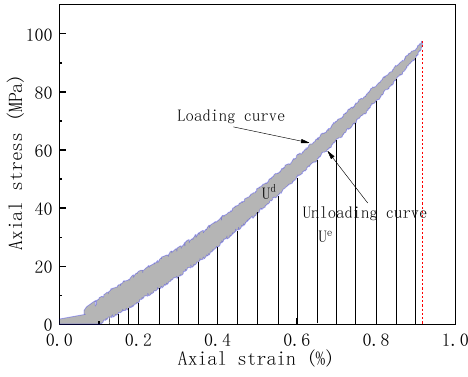
Figure 9. Distribution of elastic energy and dissipated energy of the fifth cycle at 500 °C cycle temperature.